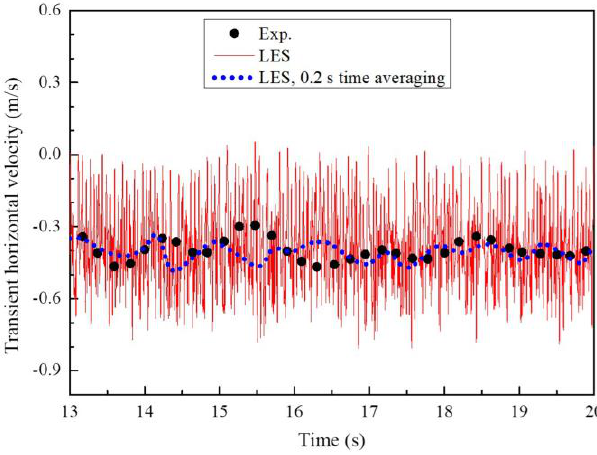
Figure 3. Transient horizontal velocity history at point 1 in the mold.